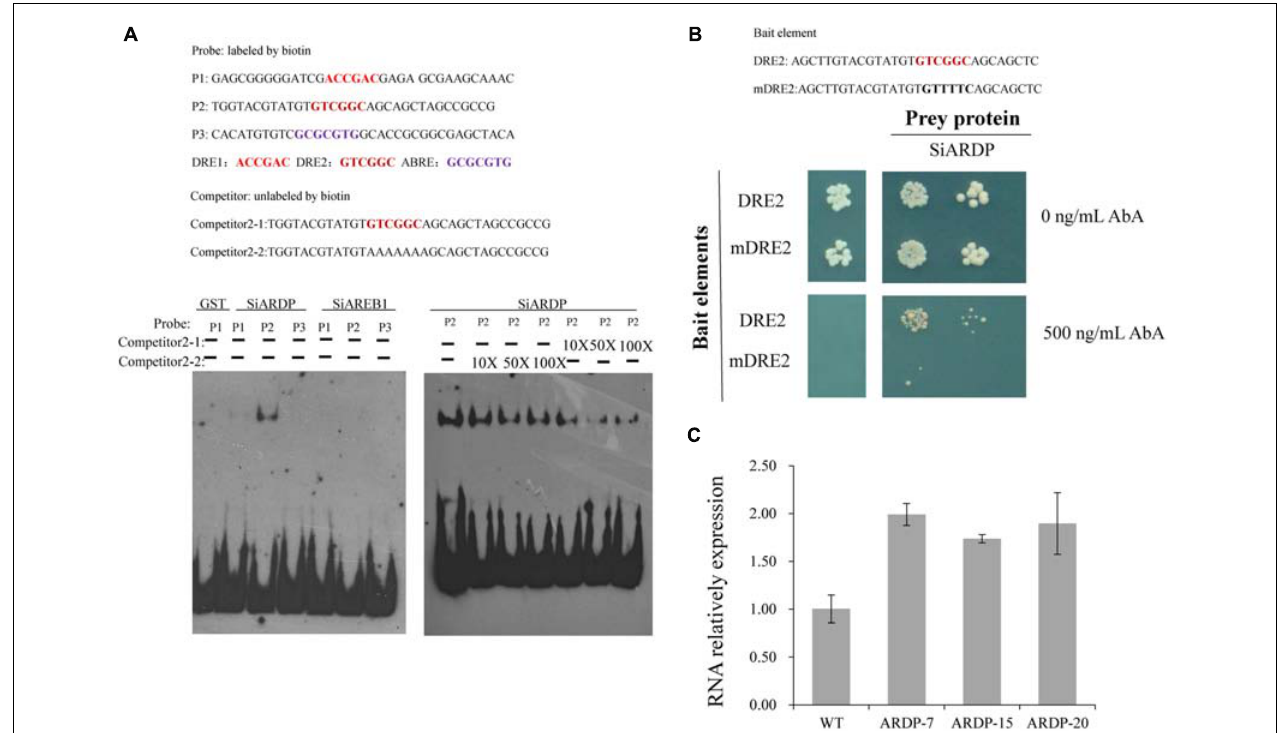
FIGURE 10 | SiARDP regulates SiLTP expression by directly binding to the DRE element. EMSA for SiARDP and SiAREB1 binding to the promoter of SiLTP (A) ; yeast one-hybrid assay for SiARDP binding to the DRE element of the SiLTP promoter (B) and the SiLTP expression levels in SiARDP transgenic foxtail millet (C) . Total RNA was extracted from 30 plants at the indicated times after the treatments. Data represent means and standard deviations for three biological